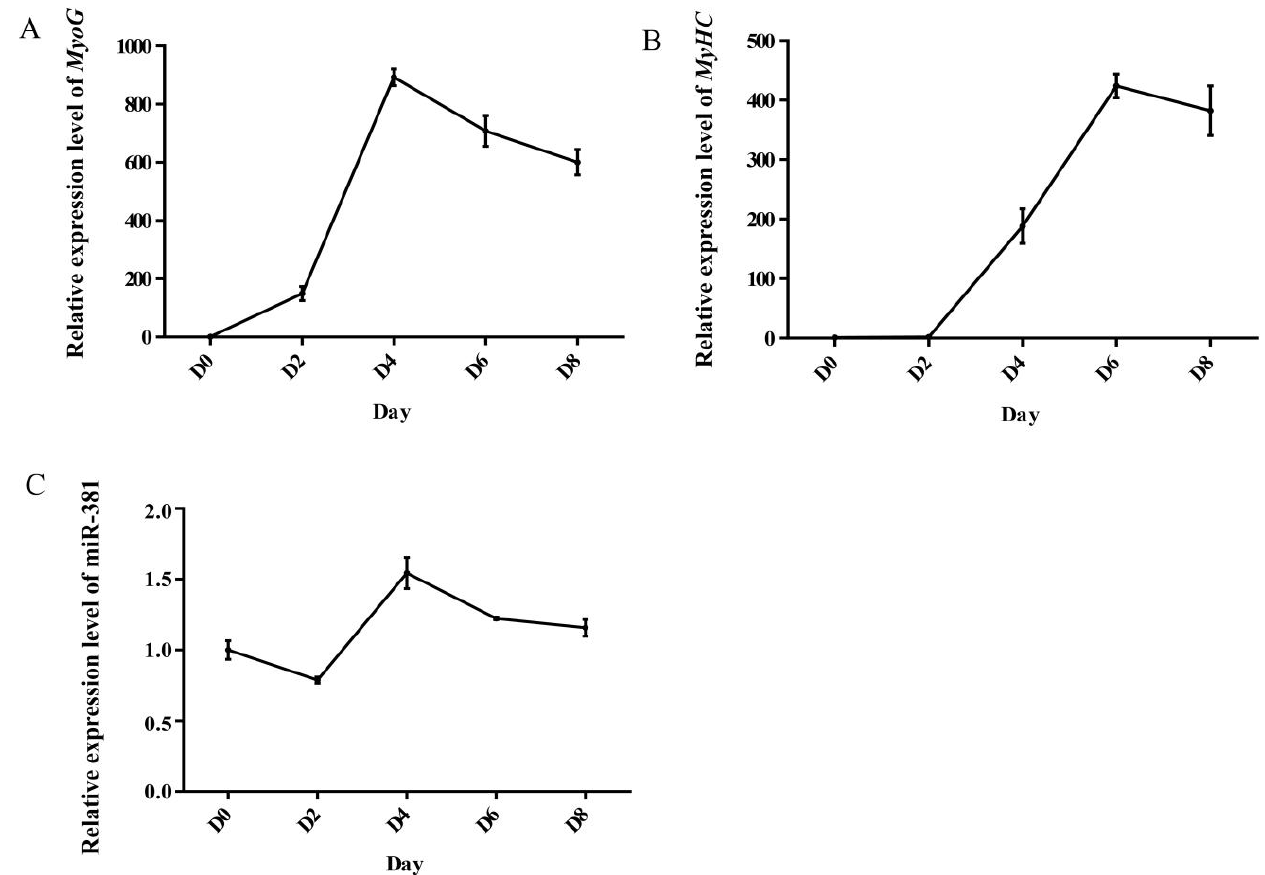
Figure 1. Expression level of MyoG ( A ), MyHC ( B ) and miR-381 ( C ) at different differentiation stages of caprine skeletal muscle satellite cells (SMSCs).